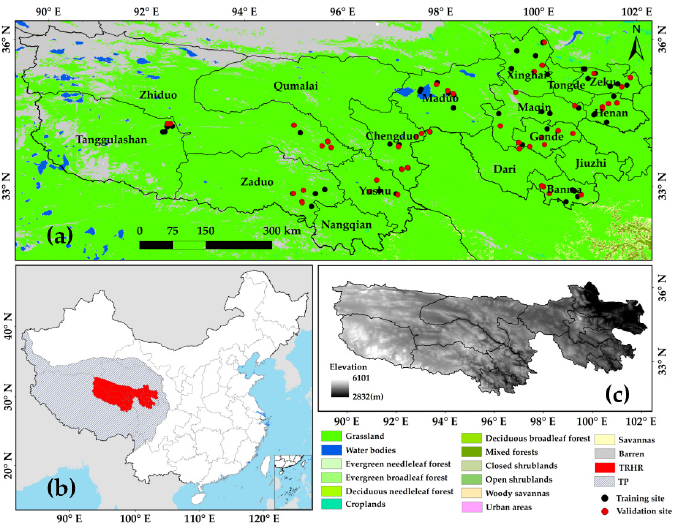
Figure 1. Maps showing the location of the study sites. ( a ) The distribution of land cover types. The black dots are training sites, and the red dots are validation sites. ( b ) The location of the Tibetan Plateau (TP) and Three-River Headwaters Region (TRHR) in China. ( c ) The elevation data of the TRHR. The study area consists of 17 counties and cities delineated by the Ecological Protection and